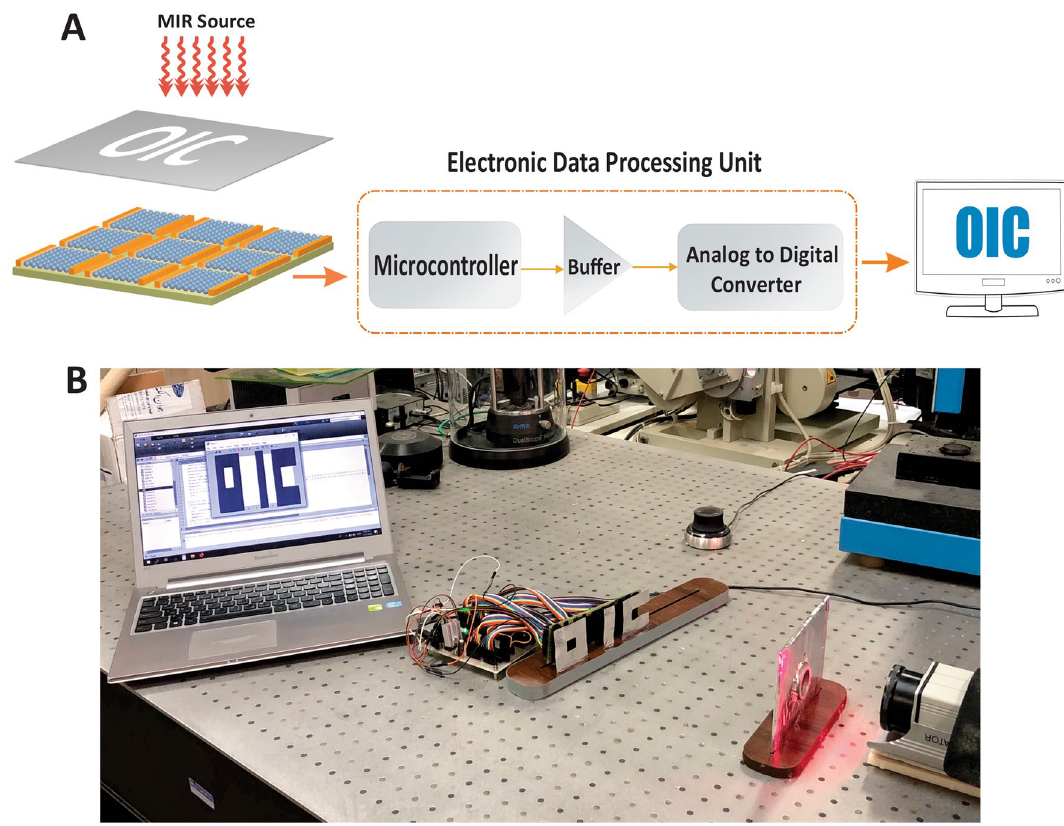
Figure 6. Imaging process by using the designed electronic circuit. ( A ) Block diagram of the electronic circuit for electrical signal-processing. ( B ) Real image of the fabricated IR